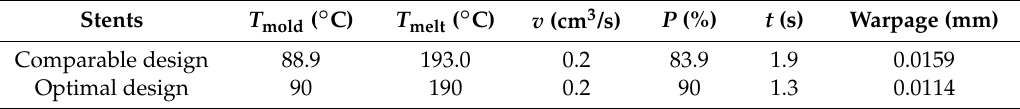
Table 2. Optimization result of stent injection molding process compared to the design point with the minimum value of optimization function among all the initial trial sample points (named comparable design).